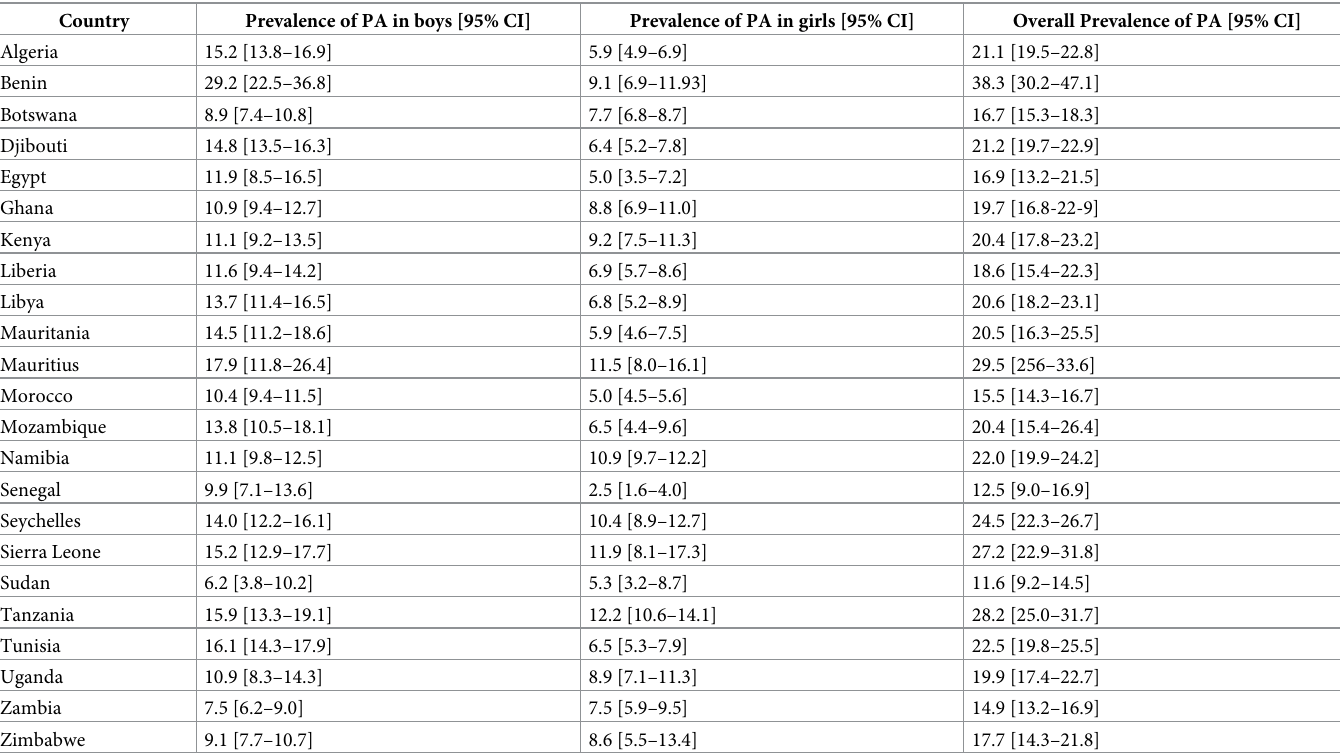
PA = Physical Activity, CI = Confidence